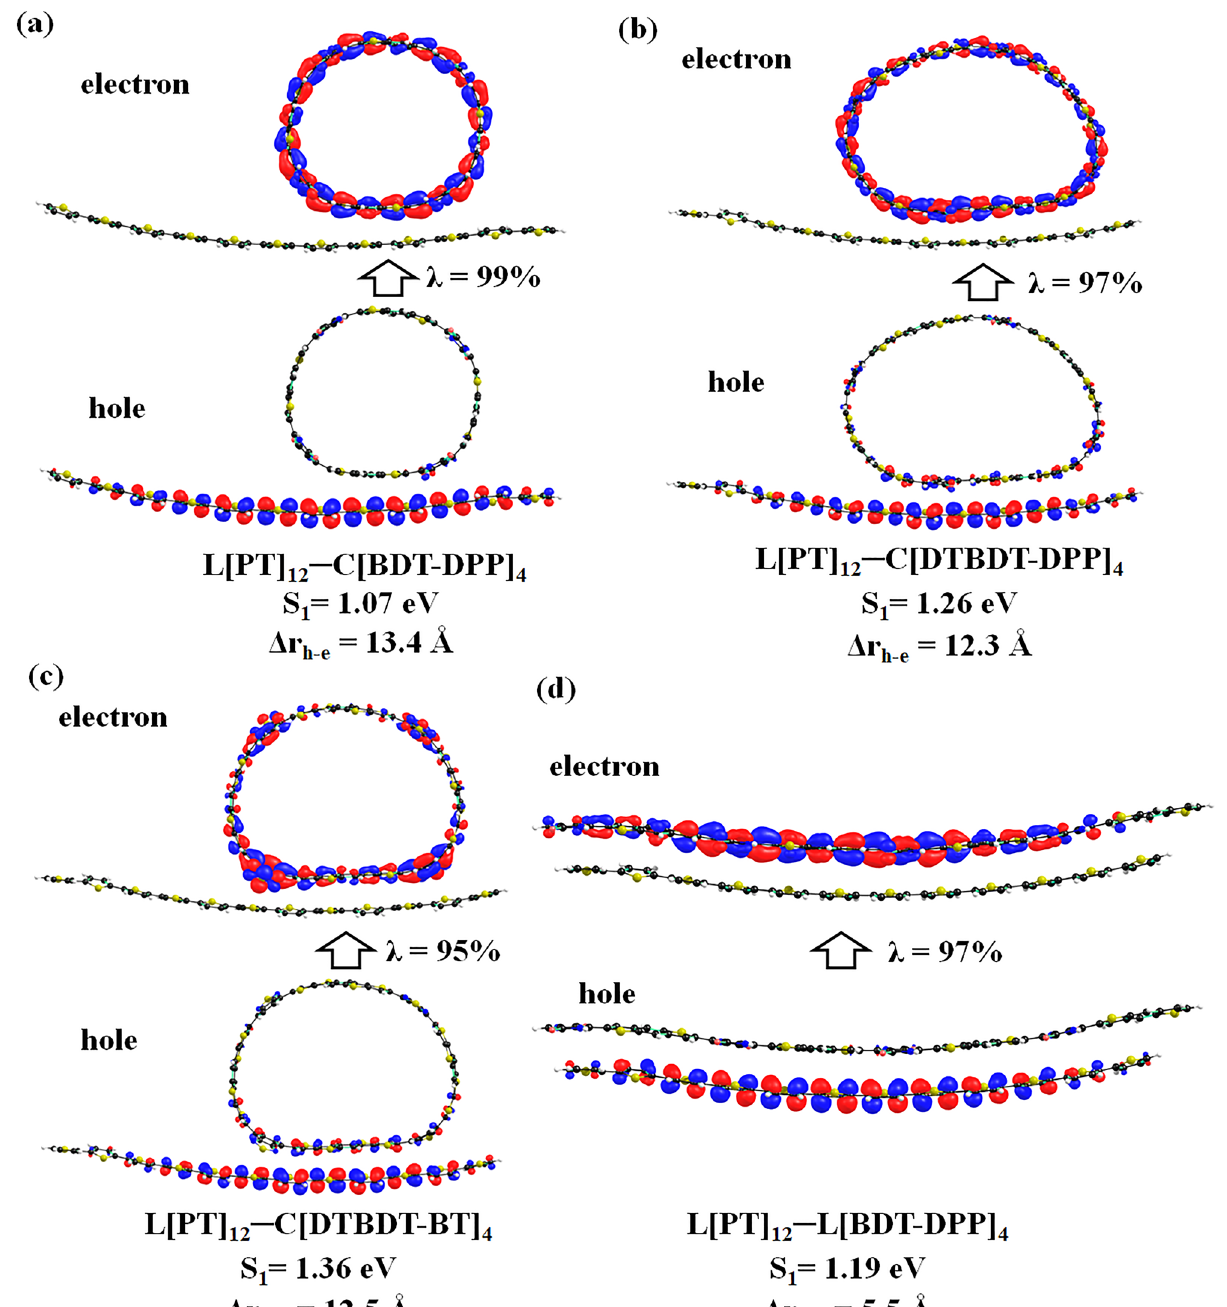
Figure 9. Pictorial representation of the charge transfer states of various cyclic-linear complexes ( a ) L[PT] 12 ─ C[BDT-DPP] 4 , ( b ) L[PT] 12 ─ C[DTBDT-DPP] 4 , ( c ) L[PT] 12 ─ C[DTBDT-BT] 4 and linear–linear complex (d)